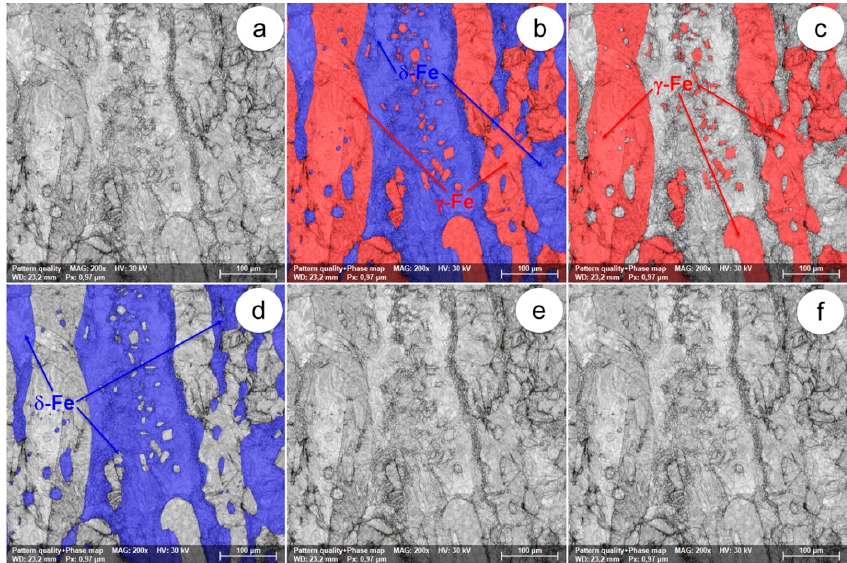
Figure 14. The SEM-EBSD composite images (×200) obtained after forging at 1050 °C: ( a ) the microstructure of the analysed field; ( b ) the distribution of existing phases in the microstructure of the analysed field; ( c ) the distribution of the γ -Fe phase; ( d ) the distribution of the δ -Fe phase; ( e ) the distribution of the σ -(Fe-Cr) phase; ( f ) the distribution of the χ -(Fe-Cr-Mo) phase.